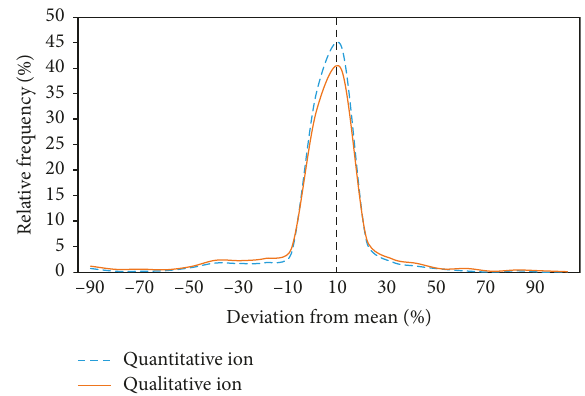
Figure 3: Distribution of the deviation of the quantitative and qualitative ion areas from the